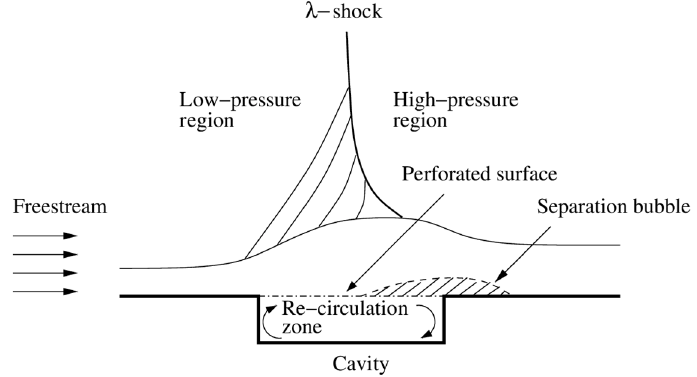
Figure 1. Schematic diagram of the wall ventilation placed at the interaction zone.